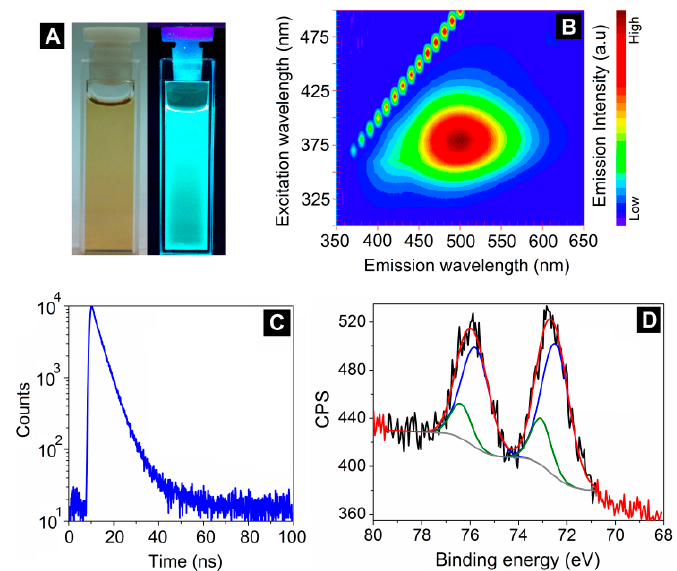
Figure 4. ( A ) Optical images under visible and 365 nm UV light, ( B ) 3D-fluorescence matrix contour plot, ( C ) fluorescence lifetime spectrum, and ( D ) deconvoluted Pt 4f XPS spectrum (blue peaks for Pt 0 and green for Pt 2 + ) of the green fluorescent Pt-NMQCs-Rec1-resilin nanobioconjugates.